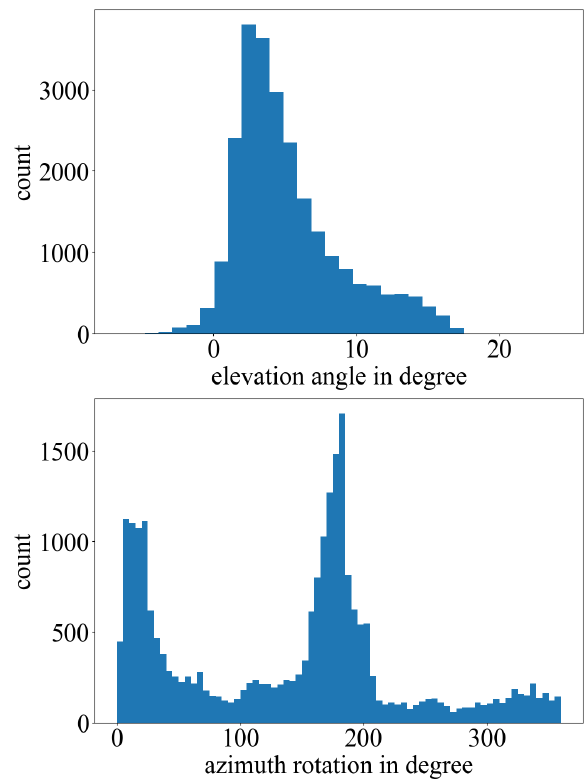
Figure 8. Distribution of the elevation angle (top, bin size of 1 ◦ ) and azimuth rotation (bottom, bin size of 5 ◦ ) in the Waymo , ShapeNet and CycleGAN